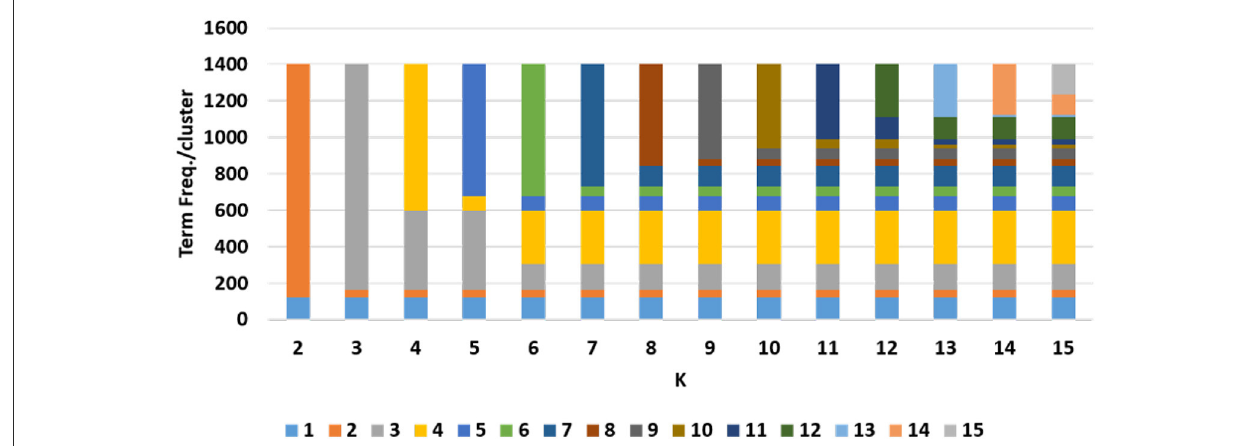
FIGURE6 Example of term frequency analysis to decide number of clusters.